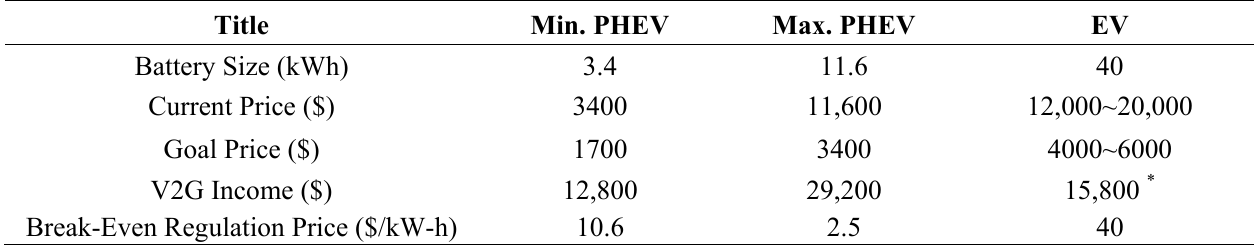
Table 2. Estimated Income of V2G regulation in comparison with battery